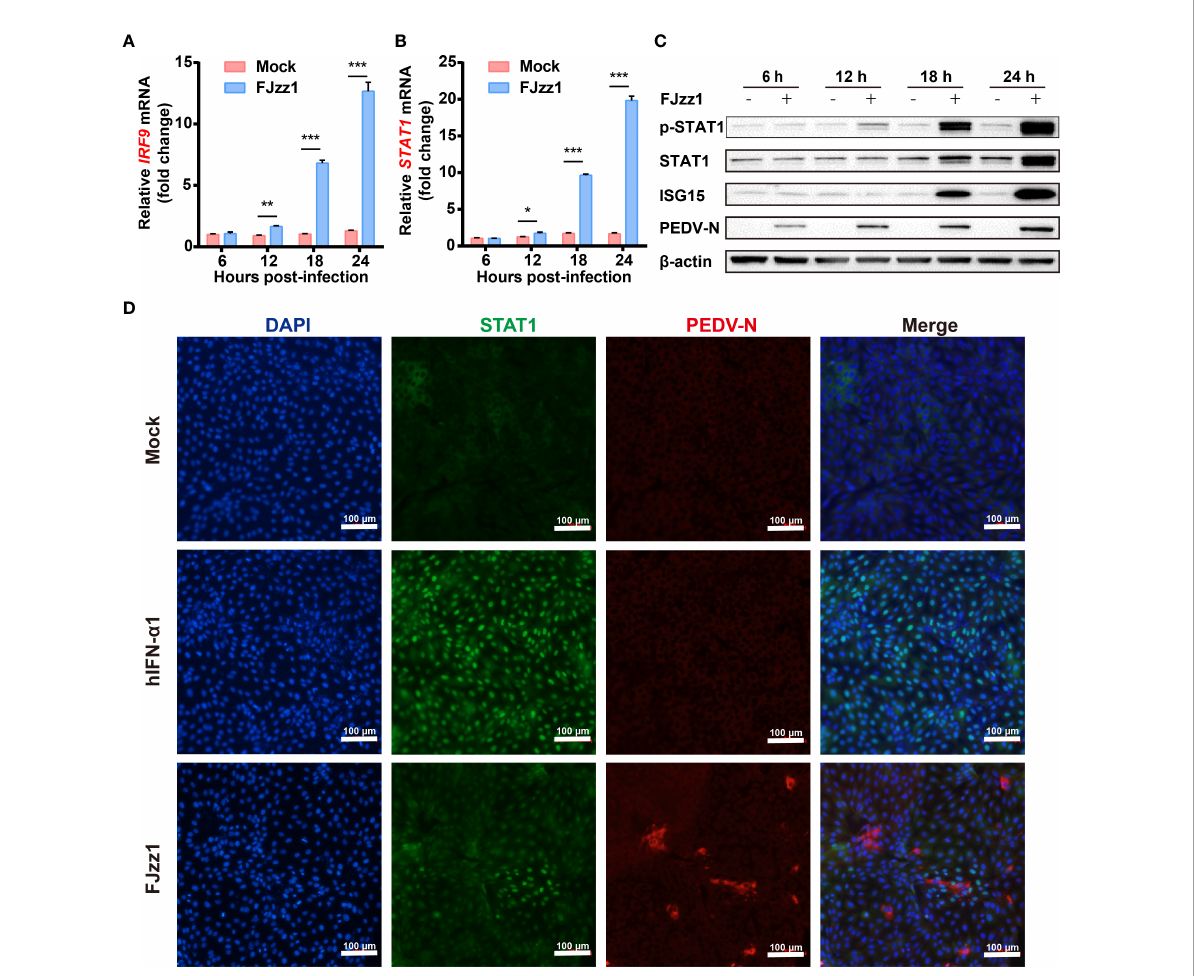
FIGURE 3 JAK-STAT signaling pathway was activated during FJzz1 infection. (A, B) Transcriptional levels of IRF9 and STAT1 in PEDV-infected cells. LLC- PK1 cells were infected with FJzz1 at an MOI of 0.01, and total cellular RNA was prepared at the indicated times post-infection to determine the IRF9 (A) and STAT1 (B) mRNA levels by RT-qPCR. (C) Expression of the phosphorylated and non-phosphorylated forms of STAT1 and the downstream ISG15 in FJzz1-infected LLC-PK1 cells. LLC-PK1 cells were infected with FJzz1 at an MOI of 0.01, and Western blotting was conducted at the indicated times post-infection using an anti-STAT1 antibody, anti-Phospho-STAT1 antibody, and anti-ISG15 antibody, respectively. (D) FJzz1 infection-induced STAT1 nuclear translocation. LLC-PK1 cells were infected with FJzz1 at an MOI of 0.01 for 18 h. Cells were then fi xed and stained with anti-STAT1 and anti-N antibodies for 1 h. Alexa Fluor 488-conjugated goat anti-mouse secondary antibody and Alexa Fluor 594-conjugated goat anti-rabbit antibody was used to visualize STAT1, and N. Nuclei were stained with DAPI. Scale bar = 100 m m. *, P < 0.05; **, P < 0.01; ***, P <